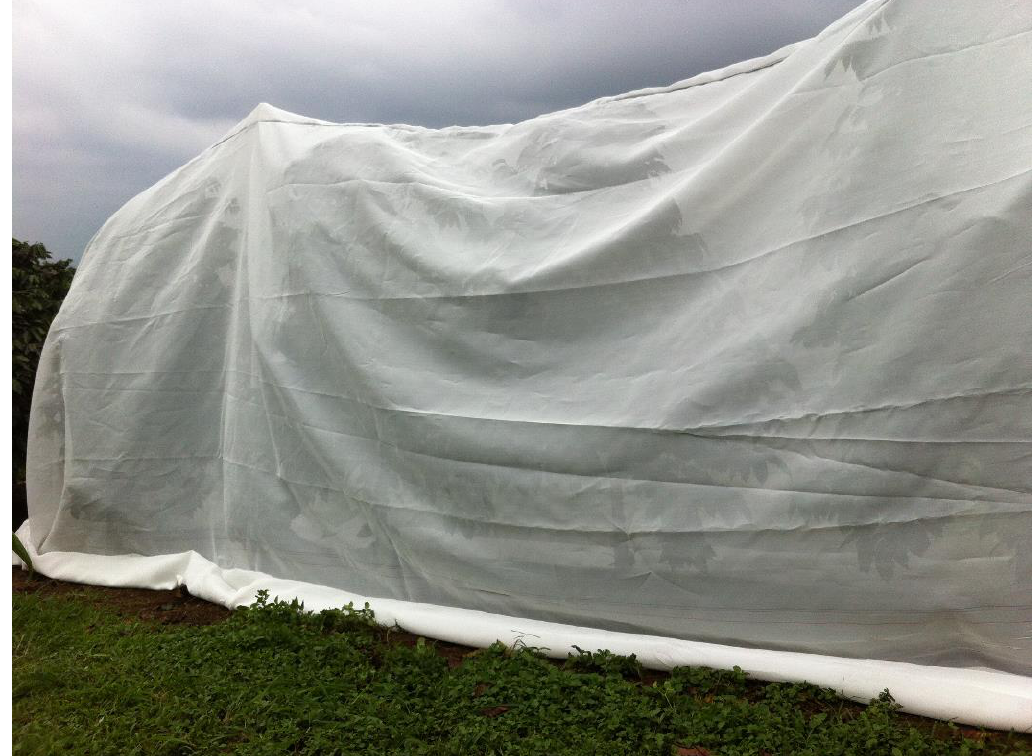
Figure 1. Photograph of exclusion plot containing five trees covered with fine-mesh netting. Four replicate exclusion plots were positioned randomly throughout each of the two farms and were paired with adjacent control (un-netted) plots.